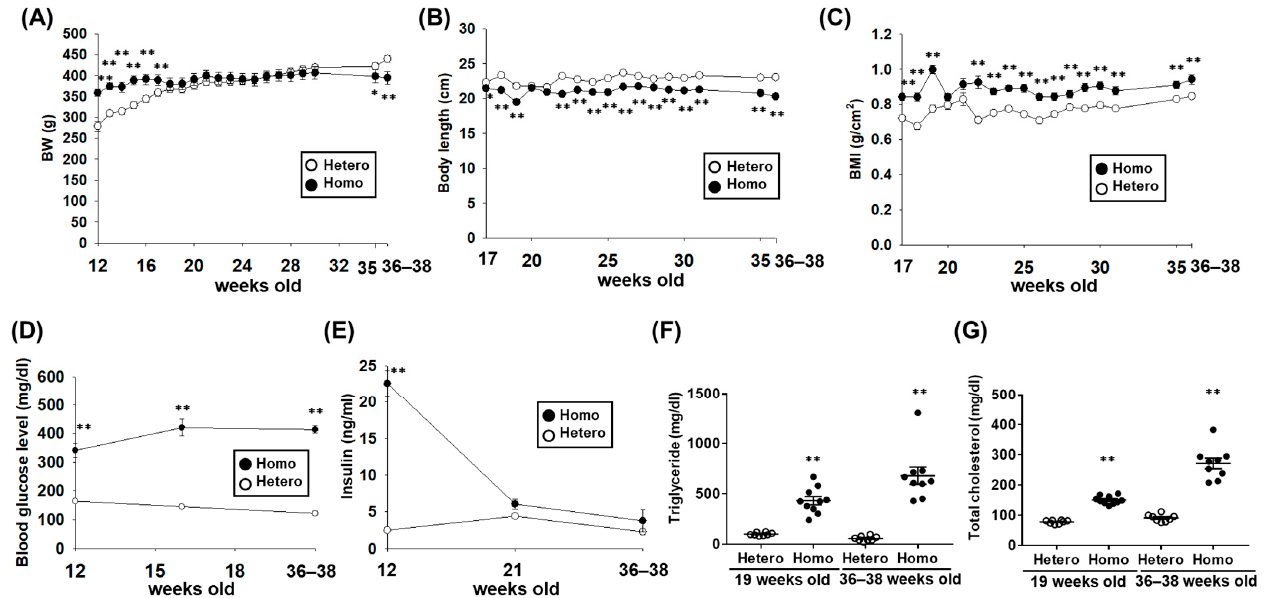
Figure 1. The metabolic characteristics of male Zucker fatty diabetes mellitus (ZFDM)-Lepr fa/+ (Het- ero) and ZFDM-Lepr fa/fa (Homo) rats. ( A ) Changes in body weight (BW) of ZFDM rats at 12 ( n = 10), 13–16 (Hetero: n = 9, Homo: n = 10), 17–35 (Hetero: n = 8, Homo: n = 10), and 36–38 (Hetero: n = 8, Homo: n = 9) weeks old. ( B,C ) Changes in body length ( B ) and body mass index (BMI) ( C ) of ZFDM rats at 17–35 (Hetero: n = 8, Homo: n = 10) and 36–38 (Hetero: n = 8, Homo: n = 9) weeks old. BMI was calculated via dividing BW by body length squared. ( D ) Blood glucose level in ZFDM rats at 12, 16 (Hetero: n = 9, Homo: n = 10), and 36–38 (Hetero: n = 8, Homo: n = 9) weeks old was determined by an enzymatic electrode method. ( E ) The insulin concentration in heparin (1 U/mL)-anticoagu- lated plasma of ZFDM rats at 12, 21, and 36–38 weeks old ( n = 5) was measured by a commercially available enzyme-linked immunosorbent assay (ELISA) kit. ( F , G ) The plasma triglyceride and total cholesterol levels of ZFDM rats at 19 and 36–38 weeks old (Hetero: n = 8, Homo: n = 10) were deter- mined by a colorimetric method. Results were expressed as means ± standard error of the mean (SEM). * p < 0.05, ** p < 0.01 vs. Hetero. Table 1. Physical and biochemical parameters in Zucker fatty diabetes mellitus (ZFDM)-Lepr fa/+ (Hetero) and ZFDM-Lepr fa/fa (Homo) rats at 36–38 weeks old. BW: body weight, BMI: body mass index, SBP: systolic blood pressure, HR: heart rate, BUN: blood urea nitrogen. Results were ex- pressed as means ± standard error of the mean (Hetero: n = 8, Homo: n = 9). * p < 0.05, ** p < 0.01 vs.